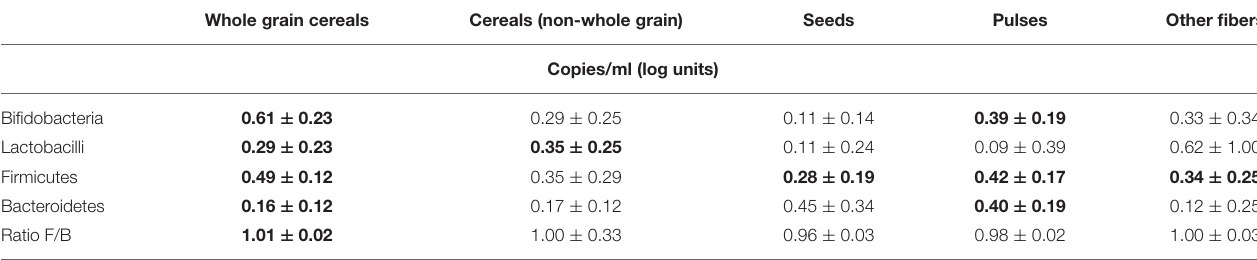
TABLE 2 | Effect of different groups of dietary fibers on specific members of gut microbiota. Whole grain cereals Cereals (non-whole grain) Seeds Pulses Other fibers Copies/ml (log units) Bifidobacteria